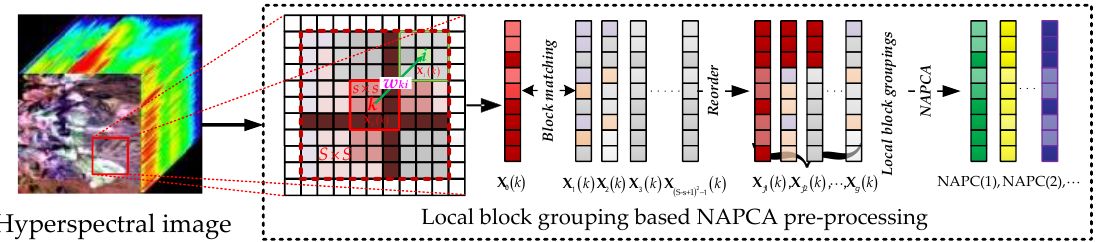
Figure 2. Basic flowchart of local block grouping–noise-adjusted principal component analysis (LBP–NAPCA) pre-processing.